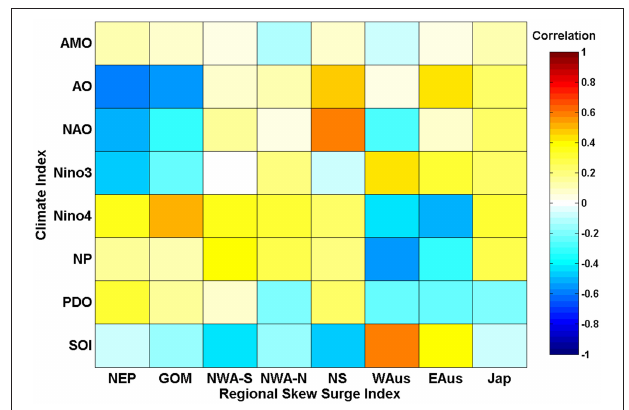
FIGURE 12 | Correlation of regional indices of skew surge against key climatic